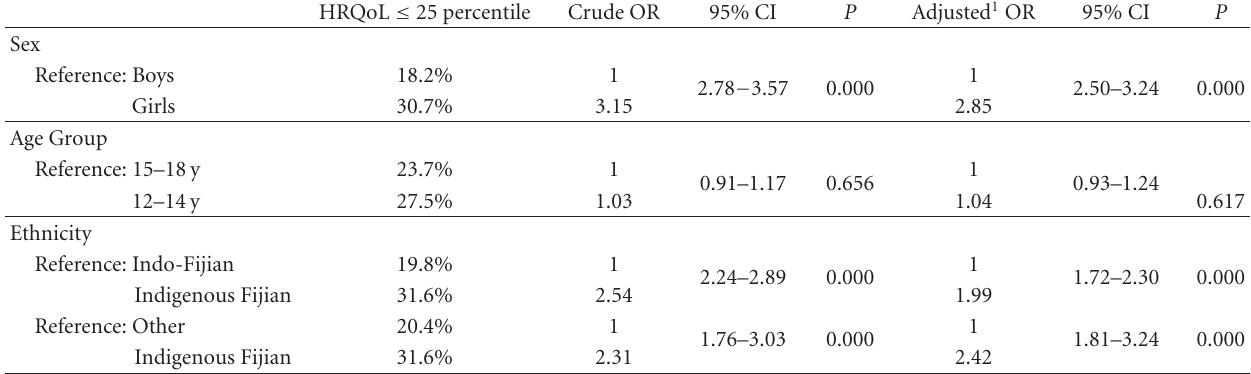
Table 4: Unadjusted and adjusted odds for health-related quality of life (HRQoL) in the lowest quartile, in sociodemographic subgroups of 12–18-year-old school children in